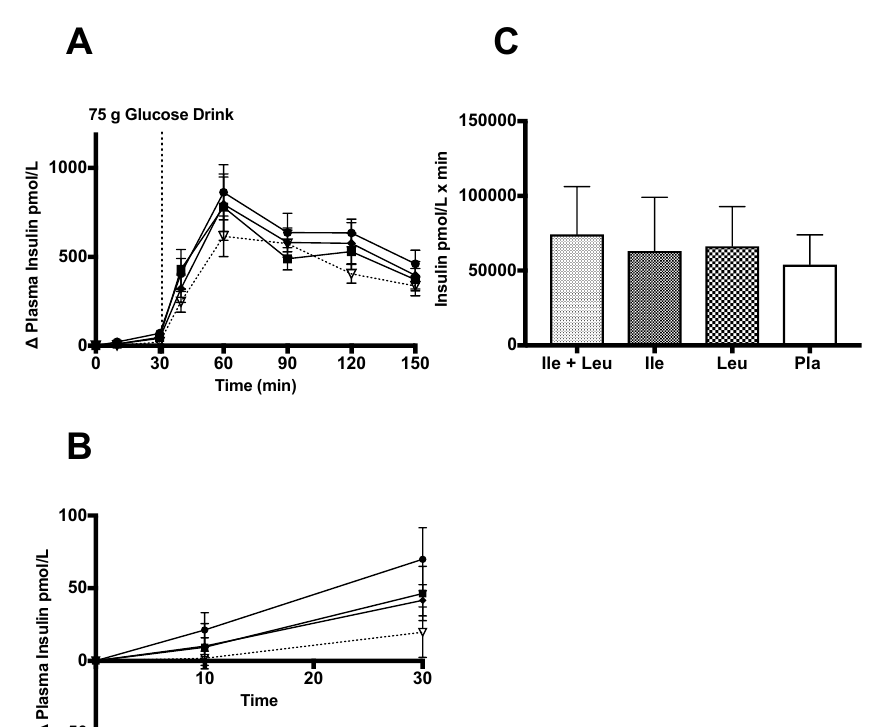
Figure 3. Plasma insulin (pmol / L) (mean ± SEM) comparing Ile + Leu, Ile, Leu, and Pla. ( A ; 0–150 min) no main treatment effect was found ( p = 0.053). ( B ; 0 – 30 min) no main treatment effect was found. ( C ; iAUC) No other differences were found ( p = 0.13).